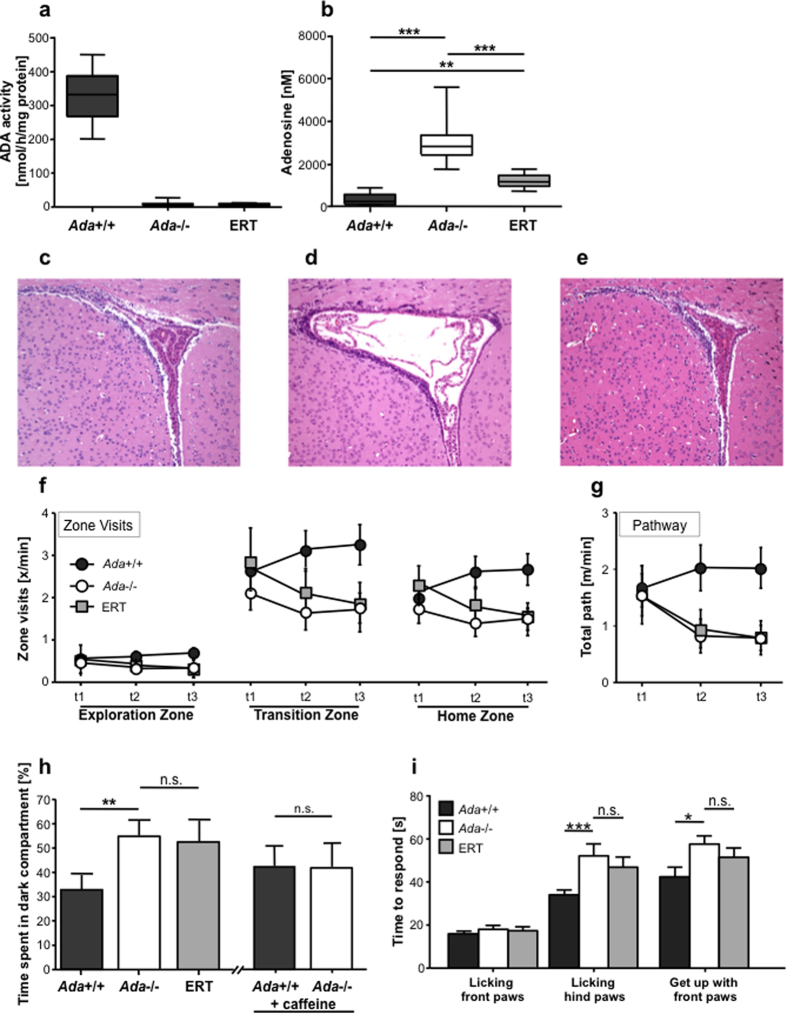
Correction of metabolic but not neurological alterations in ERT treated Ada−/− mice.(a) ADA activity/mg of total brain protein measured by HPCE-based analysis in 3 weeks old Ada+/+ (n = 9), Ada−/− (n = 11) and Ada−/− mice treated with ERT for two weeks (n = 10). (b) Concentration of adenosine levels in total brain from 3 weeks old Ada+/+ (n = 9), Ada−/− (n = 11) and Ada−/− mice treated with ERT for two weeks (n = 10); **p < 0.005; ***p < 0.0005. Hematoxylin and Eosin staining on the lateral ventricles of 3 weeks old (c) Ada+/+, (d) Ada−/− and (e) Ada−/− mice treated with ERT for two weeks; 10x. Panels Fig. 3c,d correspond to Fig. 2c,d. (f) Zone visits during Open Field test at PND15 (t1-3) of Ada+/+ (n = 25), Ada−/− (n = 20) and Ada−/− mice treated with ERT for two weeks (n = 8). (g) Total pathway during Open Field test at PND15 (t1-3) of 2 weeks old Ada+/+ (n = 25), Ada−/− (n = 20) and Ada−/− mice treated with ERT for one week (n = 8). (h) Time spent in the dark compartment during the Dark and Light Box test at PND15 of Ada+/+ (n = 29), Ada−/− (n = 33) and Ada−/− mice treated with ERT for one week (n = 8); **p < 0.005; time spent in the dark compartment in Ada+/+ (n = 20) and Ada−/− (n = 15) treated with daily i.p. injections with 50 mg/kg of caffeine; n.s. = non significant. (i) Hot plate latency to lick front and hind paws and to get up with front paws in 3 weeks old Ada+/+ (n = 23), Ada−/− (n = 21) mice and Ada−/− mice treated with ERT for two weeks (n = 8); ANOVA **p < 0.005.